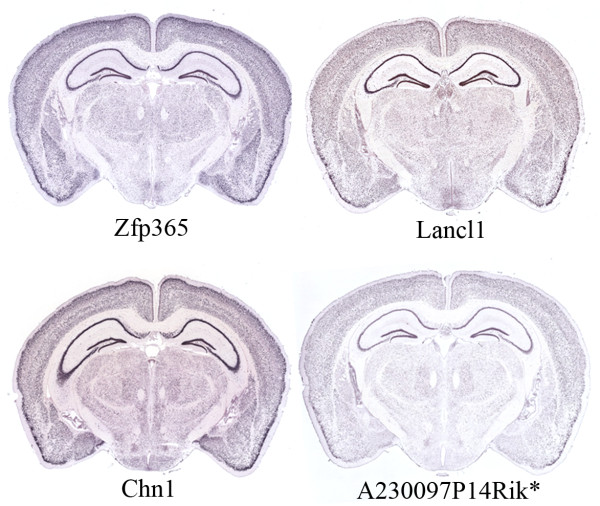
In situ hybridization of an RNA binding protein and correlated expressed probes. A representative coronal section showing in situ hybridization data from Zfp365, Lancl1, Chn1, and A230097P14Rik*. All probes show strong widespread expression throughout the brain.